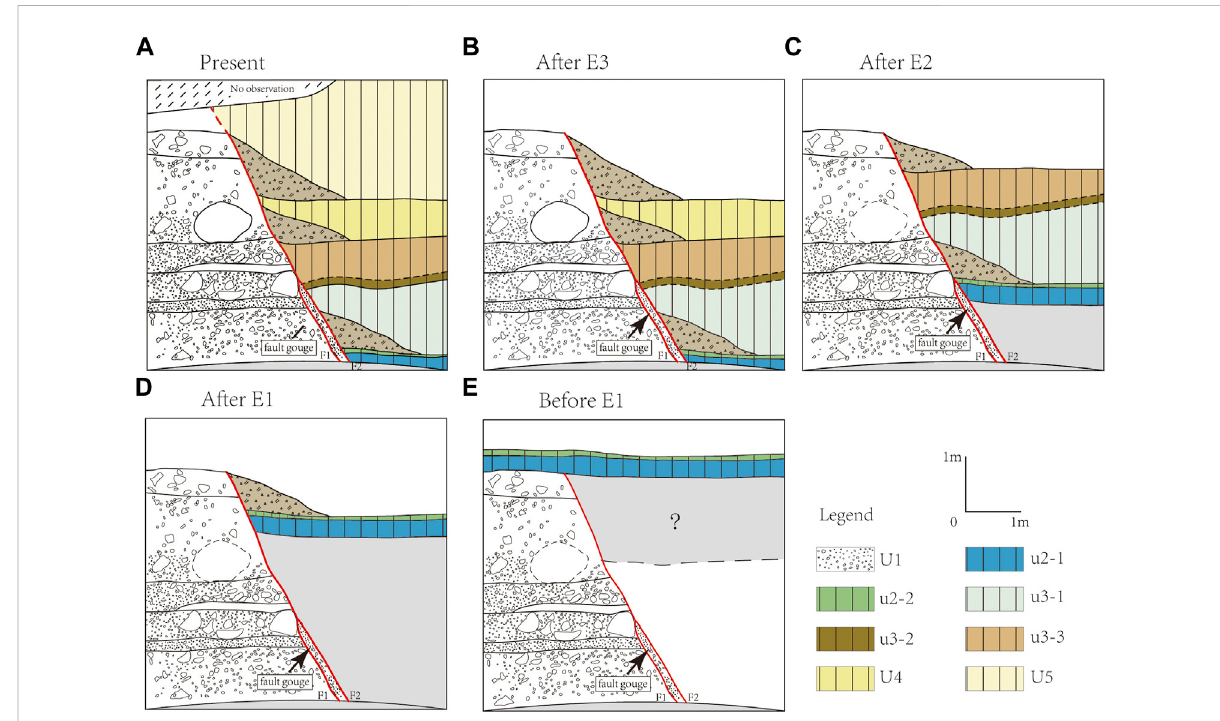
FIGURE 12 Possible restoration of the stratigraphy of the Luofengwa pro fi le, showing the deformation associated with events E1 to E3. (A) Present-day situation; (B) E1occurredafterthedepositionofu4,andcolluvialwedgeW1formed; (C) E2occurredafterthedepositionofu3-3,andcolluvialwedge W2 formed; (D) E3 occurred after the deposition of u2-2, and colluvial wedge W3 formed; and (E) possible original situation before E3.